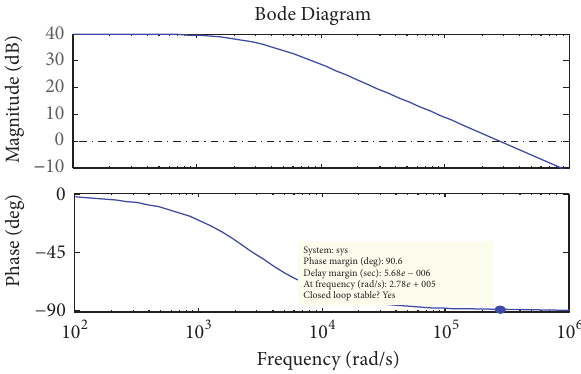
Figure 14: Frequency response of the capacitor